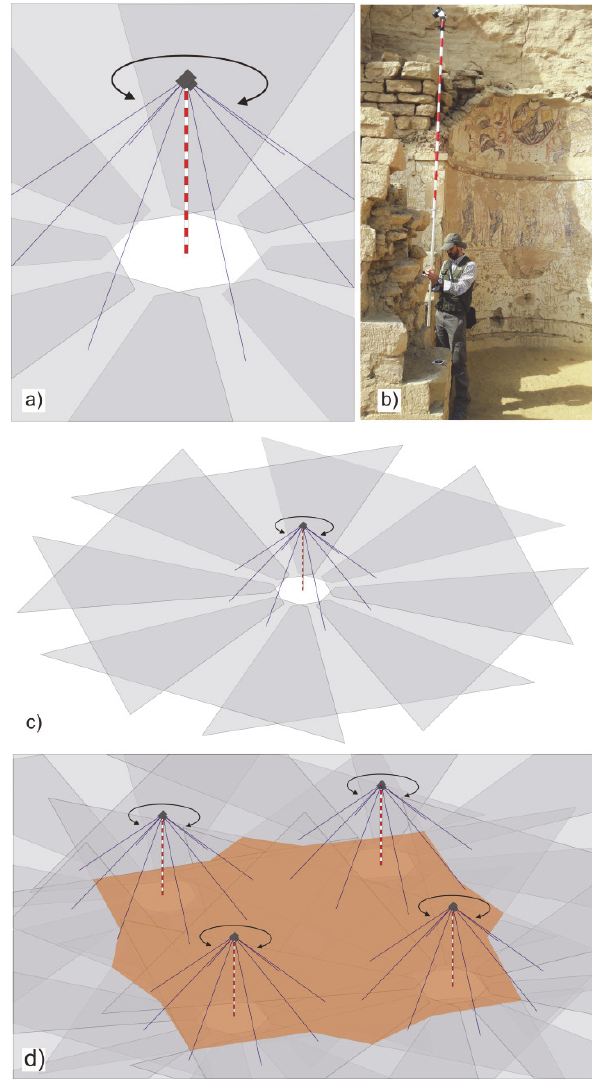
Figure 3. Acquisition of photographs using a mast based on Pérez et al. (2018): a) detailed view of the system; b) example